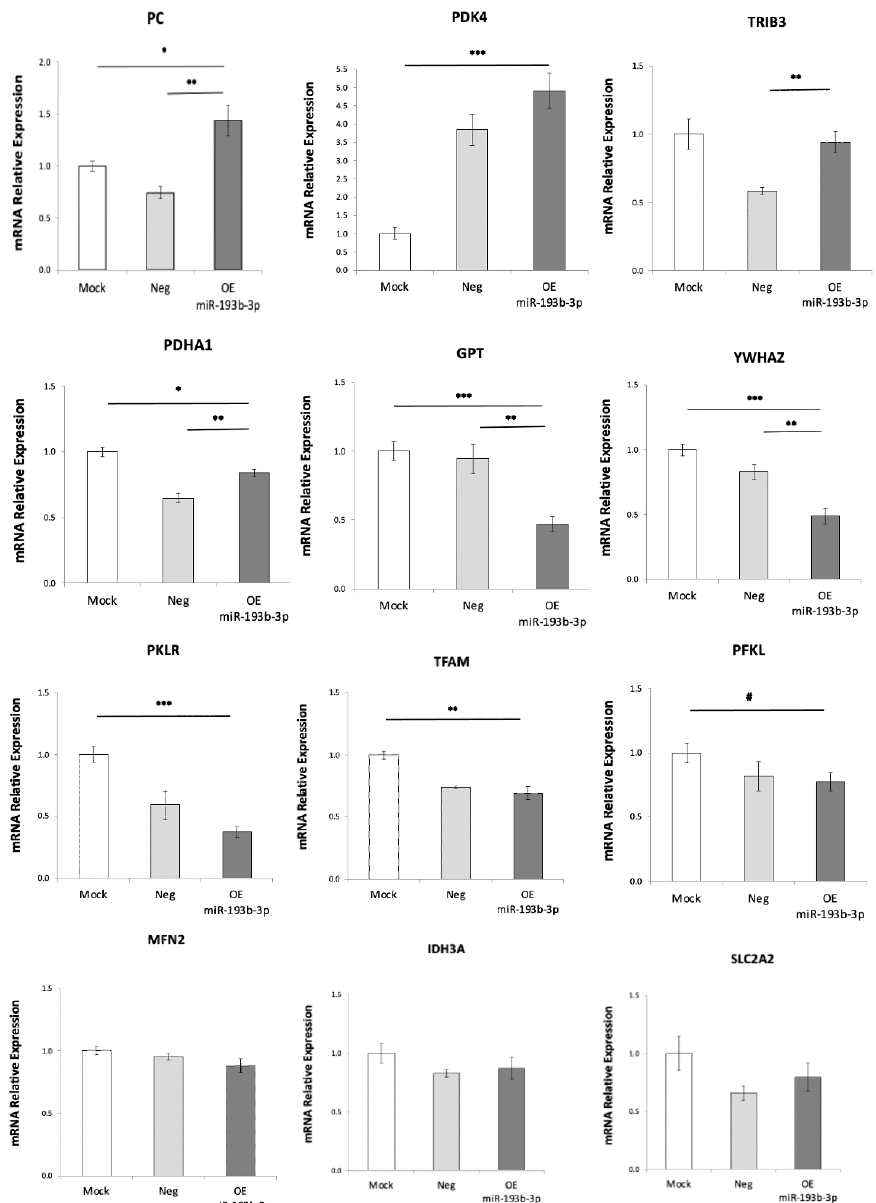
Figure 4. Changes in expression of genes regulating insulin signaling, glucose metabolism, pyruvate availability and mitochondrial biogenesis when hsa-miR-193b-3p is overexpressed in HepG2 cells. Downregulation of YWHAZ indicates increased insulin signaling. Increased pyruvate carboxylase ( PC ). Reduced trend in glucose transporter SLC2A2 /GLUT2 indicates reduced glucose transport. Reduced levels of phosphofructokinase ( PFKL ) and pyruvate kinase ( PKLR ) indicate reduced glycolysis. Reduced levels of pyruvate dehydrogenase PDHA1 and increase in its inhibiting kinase PDK4 indicate lower conversion of pyruvate to acetyl-CoA. Reduced glutamic–pyruvic transaminase GPT indicates lower conversion of alanine to pyruvate. Reduced levels of mitochondrial transcription factor A ( TFAM ), and reduced trend in mitofusin 2 ( MFN2 ) and isocitrate dehydrogenase 3 catalytic subunit alpha ( IDH3A ) indicate reduced levels of mitochondrial biogenesis, fusing dynamics and function, respectively. Relative mRNA expression was evaluated by real-time RT-qPCR after 72 h overexpression of hsa-miR-193b-3p in HepG2 cells under hyperglycemia/hyperinsulinemia (20 mM glucose, with 10 nM insulin during last 24 h). Data are presented as mean ± SEM of n = 4. Mock—mock transfection, OE—overexpression of hsa-miR-193b-3p. Student’s t -test p -values indicated by # < 0.1, * < 0.05, ** < 0.01, *** < 0.001.